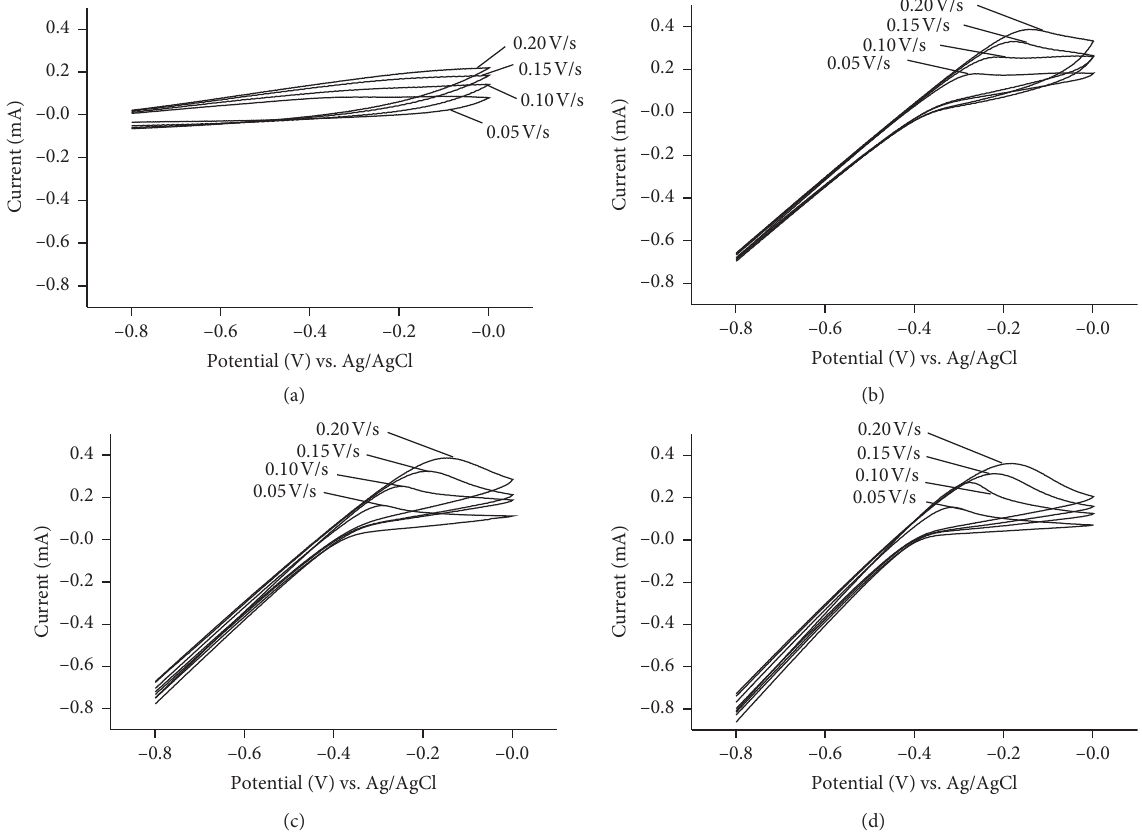
Figure 2: Cyclic voltammograms of (a) FeG 10mM solution, (b) FeG 10mM-Ac 2.5% solution, (c) FeG 10mM-Ac 2.5%-Ch 0.5% solution, and (d) FeG 10 mM-Ac 2.5%-Ch 0.5%-Tp 0.25% solution, at v values of 0.5, 0.10, 0.15, and 0.20V/s.